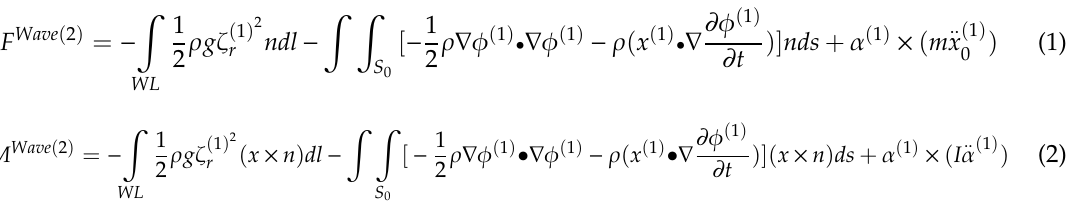
Figure 3. FAST-UOU Figure 3. FAST-UOU structure.